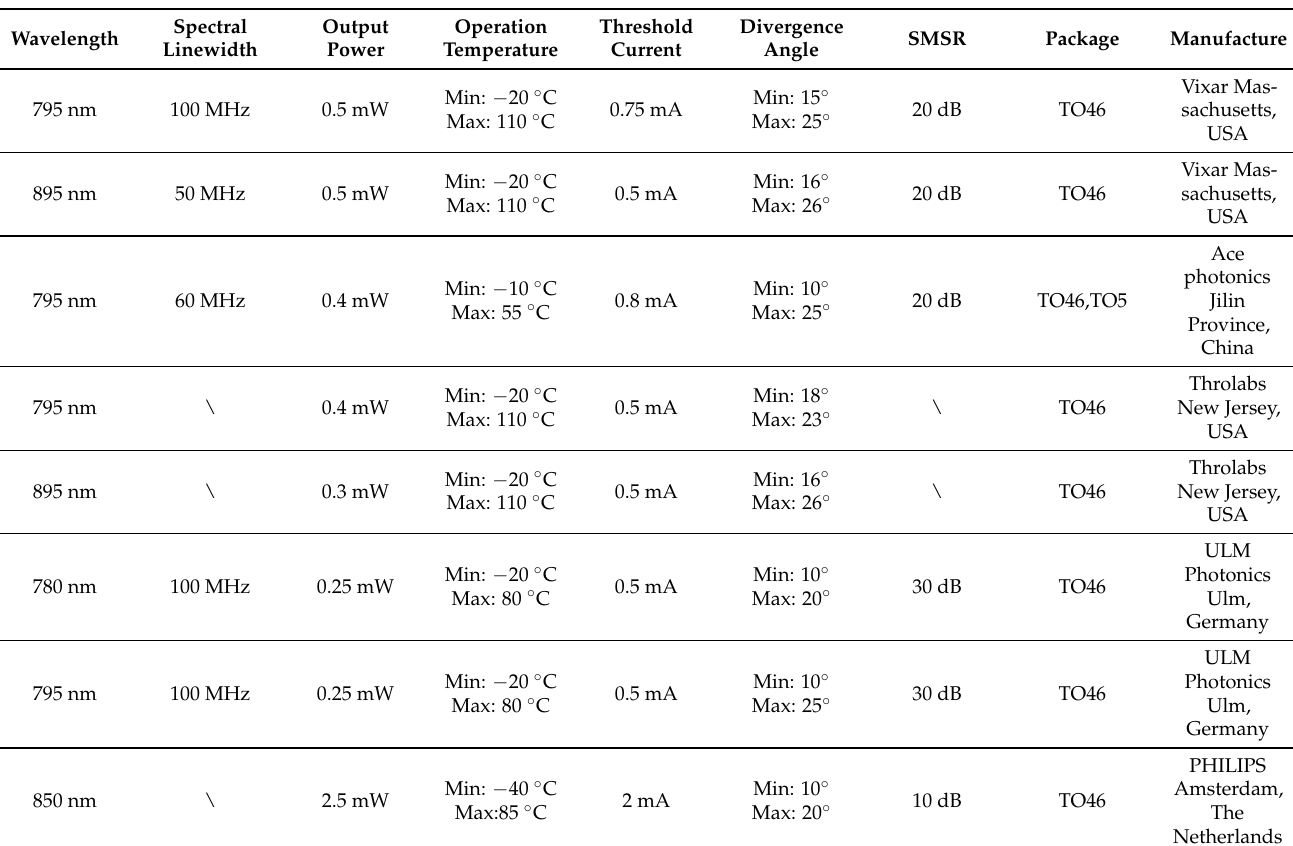
Table 3. Current commercial VCSELs for atomic